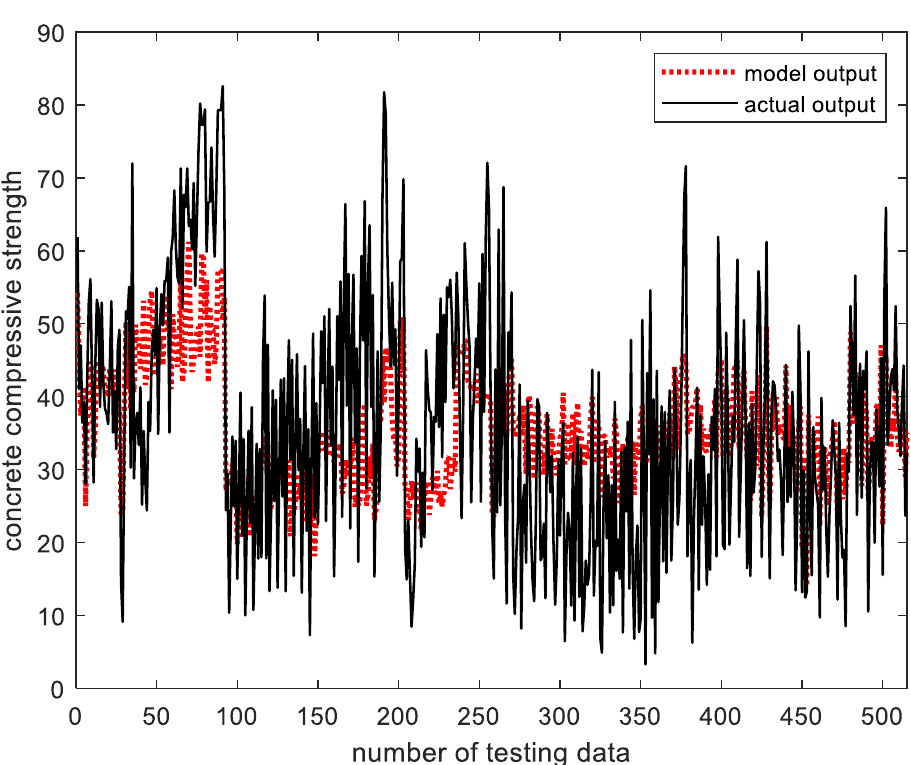
Figure 18. Comparison of the output value of the existing CGK-GM with the actual output value (context is created equally, the number of contexts = 6, the number of clusters = 4).